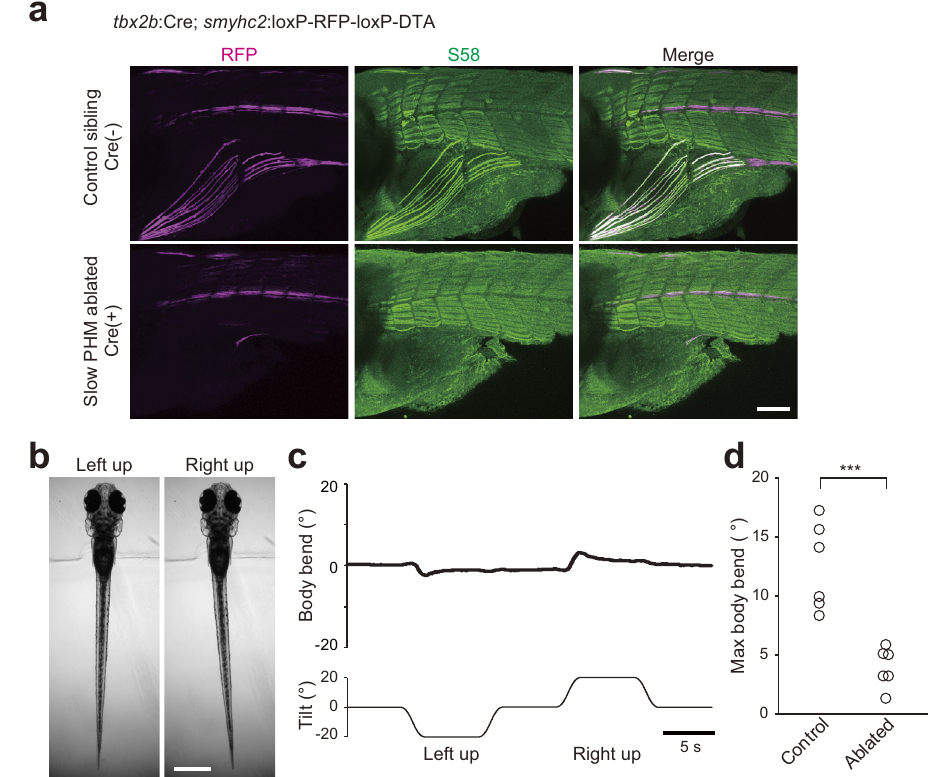
Fig. 9 | Ablation of slow-type PHMs impairs the VBR. a Images of immunohis- tochemistry with S58 antibody against Tg( smyhc2 :loxP-RFP-loxP-DTA) fi sh. Top: images of a fi sh without tbx2b :Cre (control). Bottom: images of a fi sh with tbx2b :Cre. b Behaviors of Tg( tbx2b :Cre; smyhc2 :loxP-RFP-loxP-DTA) fi sh in the head-embeddedconditionduringrolltilts. c Timecourseofthebodybendanglein